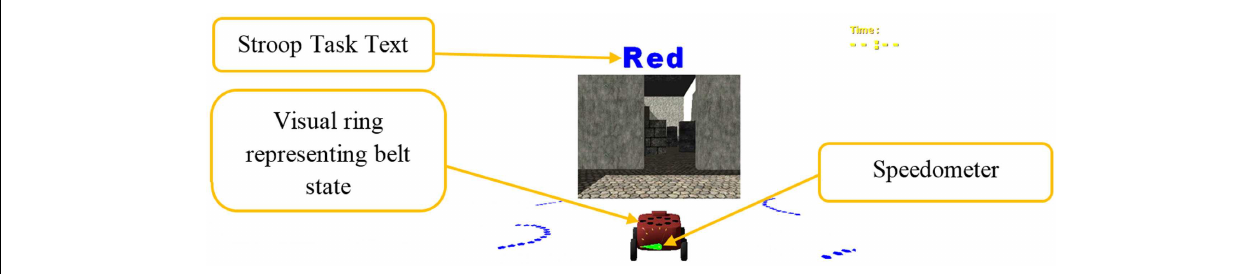
FIGURE 6 | Study #3 visual components .The visual ring and speedometer are only part of Interface